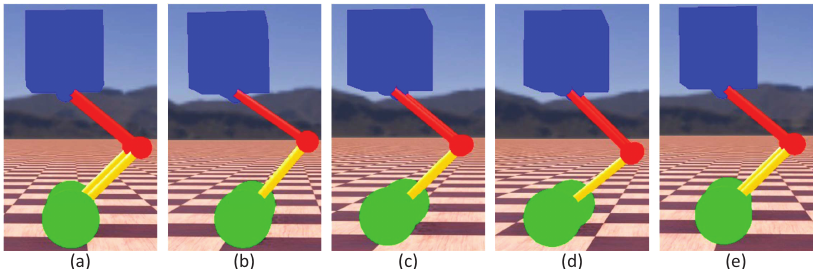
Figure 9. Snapshots of the simulation for the velocity tracking. Photos ( a , e ) represent the initial standing state and final stopped state of the robot, respectively. Photo ( b ) shows the process of accelerated motion of the robot. Photo ( c ) shows the state of the robot moving at a constant speed. Photos ( d ) represent the deceleration phase of the robot.